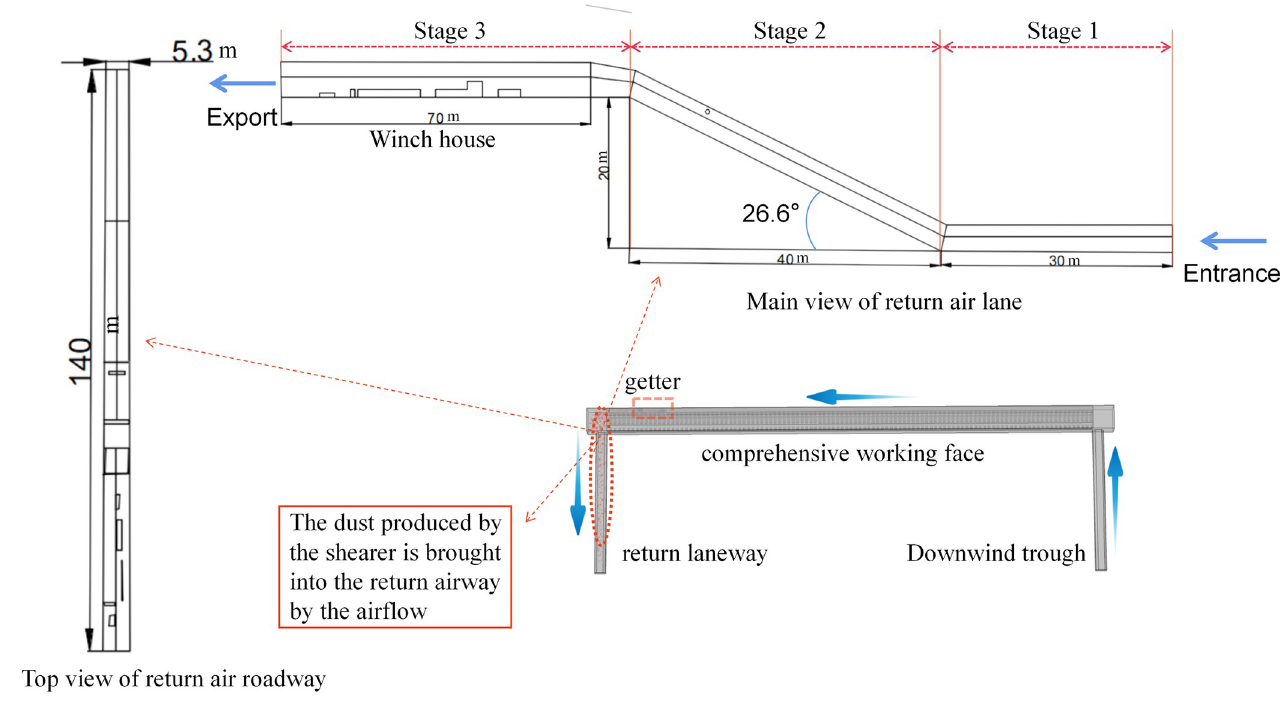
Fig 3. Model of the return air